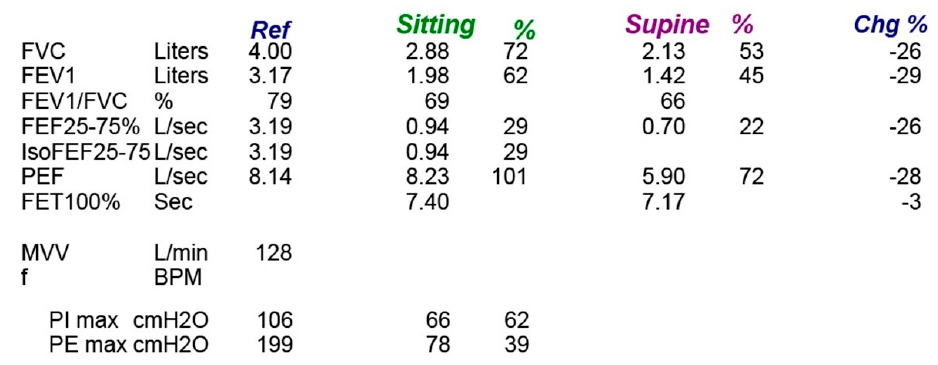
Figure 5. Spirometry of patient with bilateral diaphragmatic palsy showing significant drop of lung functions on supine